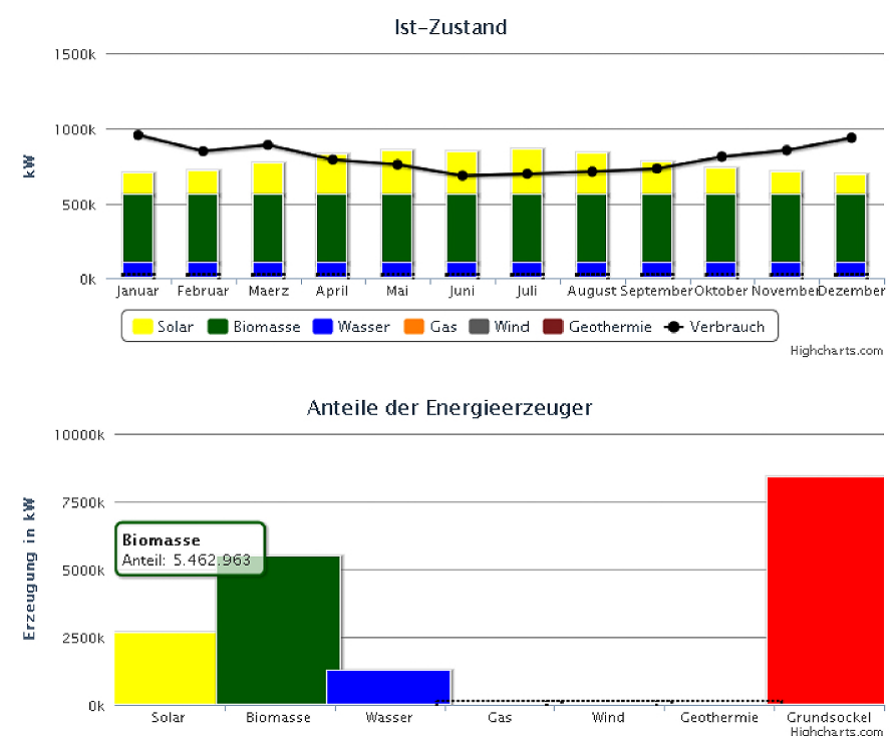
Figure 9. An example of a visualization used as part of a simulation tool. The bars shown in the lower part represent different energy resources. The share of a resource can be changed by interactively changing the height of its corresponding bar. Image from Reference